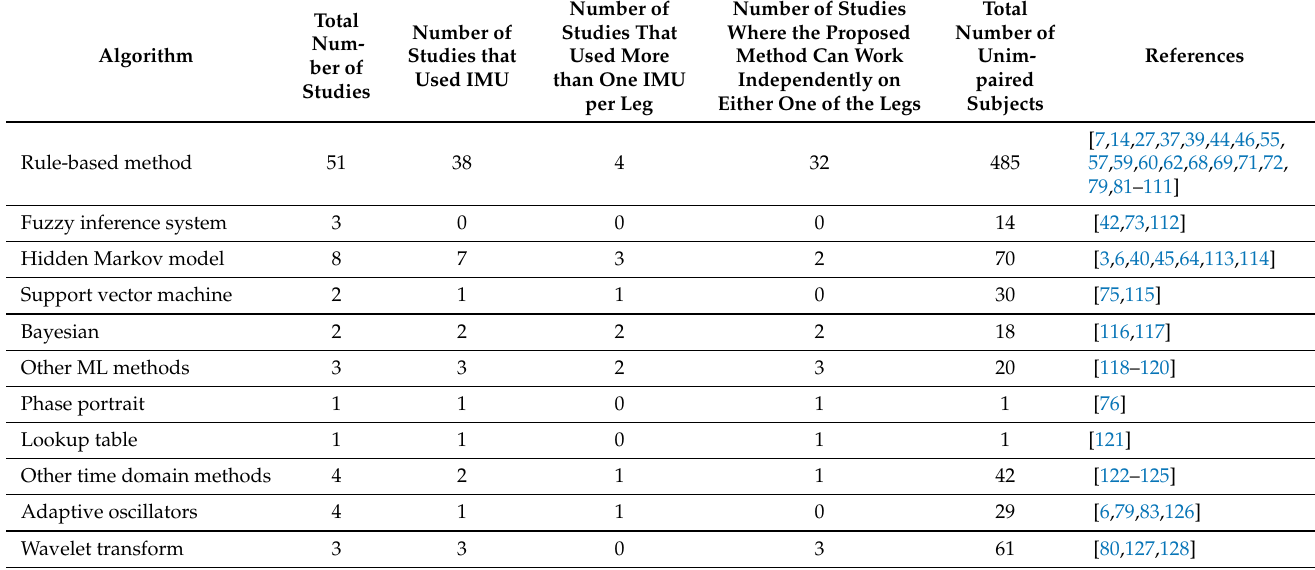
Table 5. Distribution of gait detection techniques for studies that validated on unimpaired subjects. Details on the usage of inertial measurement units (IMU) are presented together with the total number of unimpaired subjects the algorithms types were validated on. ML—Machine